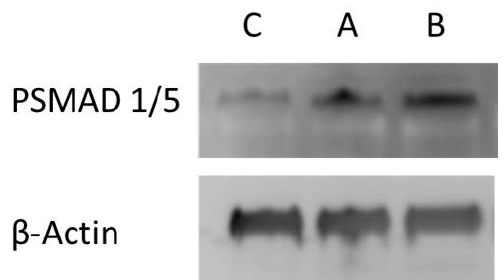
Figure 8. Biological activity of BMP-2 released from PNIPAM-DMAEMA coatings for 24 h at T = 37 °C (sample A) and T = 47 °C (sample B). The activation of SMAD mediated pathway in mouse C2C12 myoblasts stimulated by BMP-2 is shown by phosphorylation of SMAD 1/5 by Western Blotting on native and released BMP-2. For negative control an equal amount of buffer without BMP-2 was used